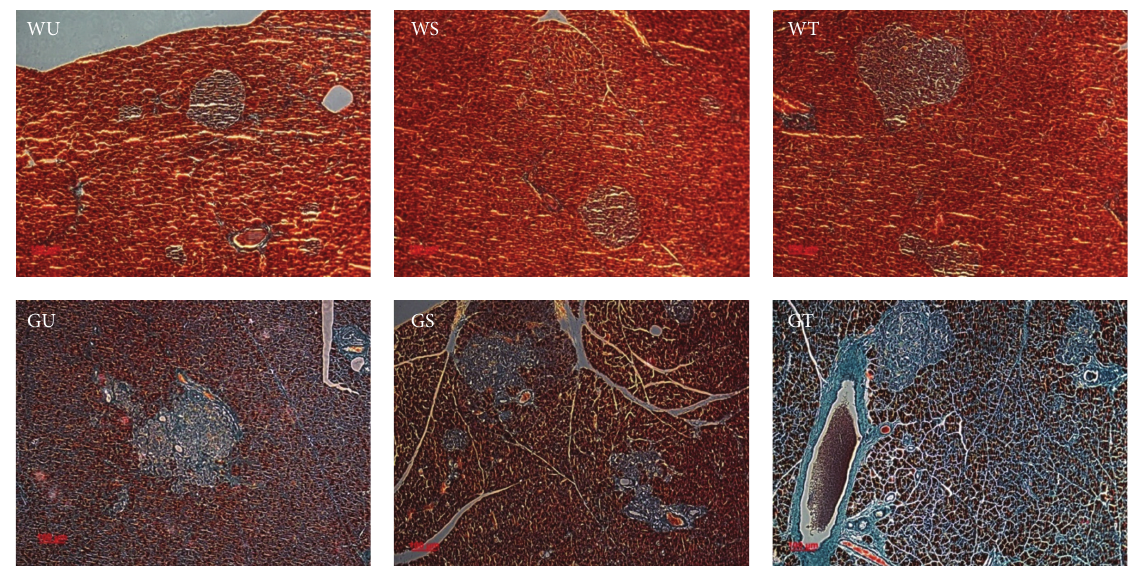
Figure 3: Intrapancreatic PSCs increase islet fibrosis in vivo . Masson’s trichrome staining was performed to show the islet fibrosis. The degree of islet fibrosis in GK rats was higher than that in normal Wistar rats, and the extent of islet fibrosis in GK rats was significantly increased after intrapancreatic transplantation of PSCs. All images were taken at the same magnification ( × 200).